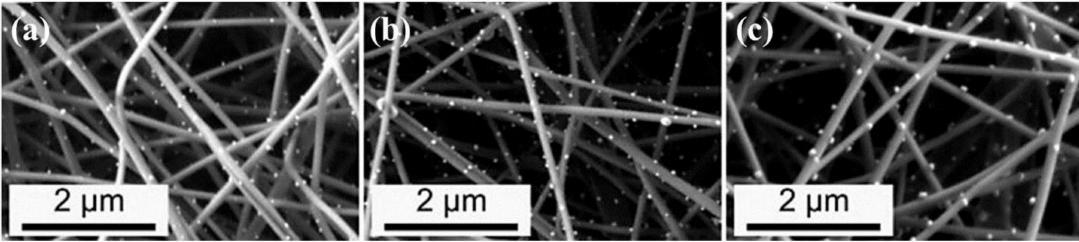
Figure 14. SEM images of Ag/cellulose nanofibers (CNFs) with the Ag loading amounts being ( a ) 11 wt. %; ( b ) 15 wt. %; and ( c ) 25 wt. % [190]. Reproduced with permission from ref. [190]. Copyright Elsevier,